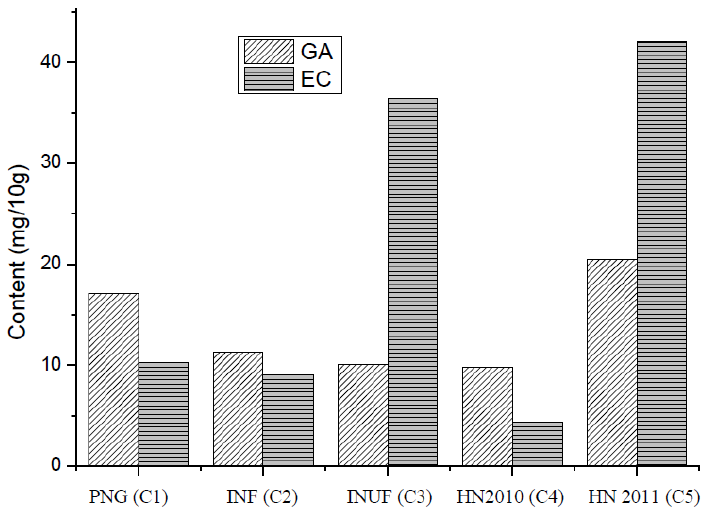
Figure 2. The content of gallic acid and epicatechin per 10.0 g of